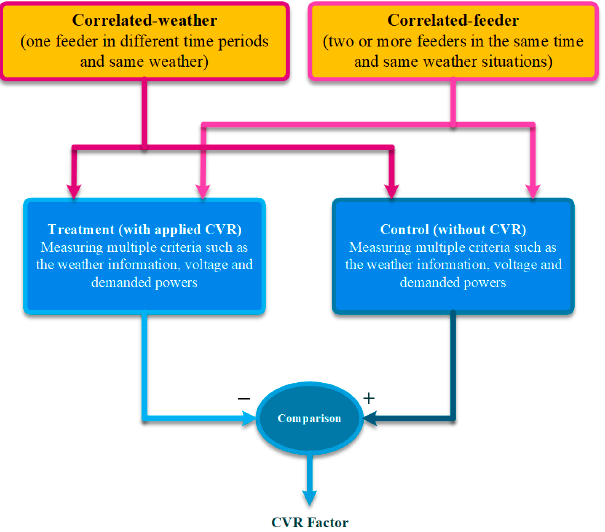
Figure 14. Structure of the comparison-based CVR quantification method [107].